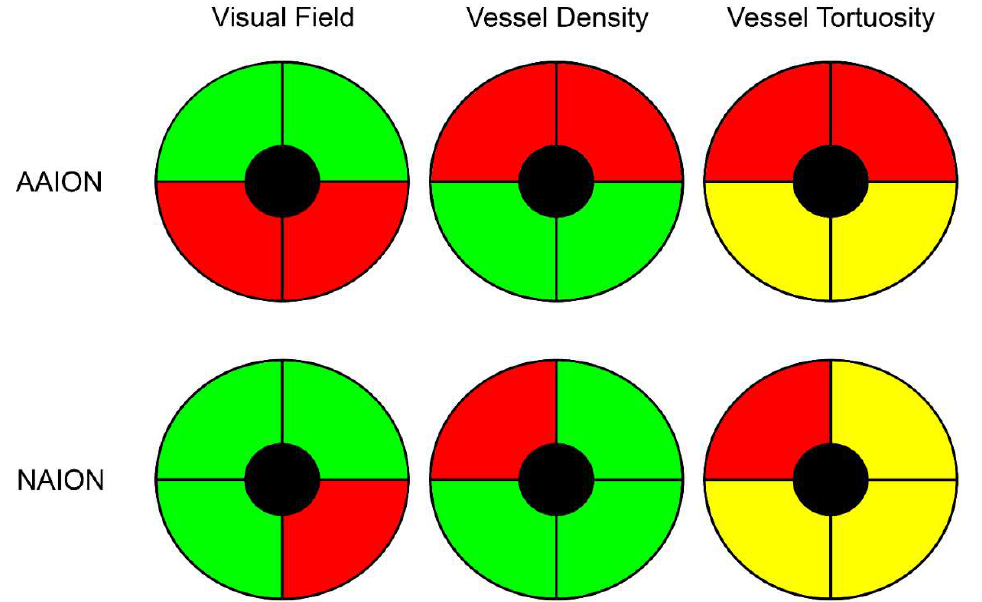
Figure 2. Schematic representation of vessel density and vessel tortuosity defects in anterior ischemic optic neuropathies. Although visual field defects were more pronounced in AAION than NAION, both diseases showed a perfectly matched vessel density reduction (red quadrants), with unremarkable changes in the other sectors (green quadrants), compared to healthy controls. On the other hand, vessel tortuosity registered the worst values in the affected quadrants (red quadrants), but statistically significant lower values were also found in the unaffected quadrants (yellow quadrants), with respect to healthy controls.